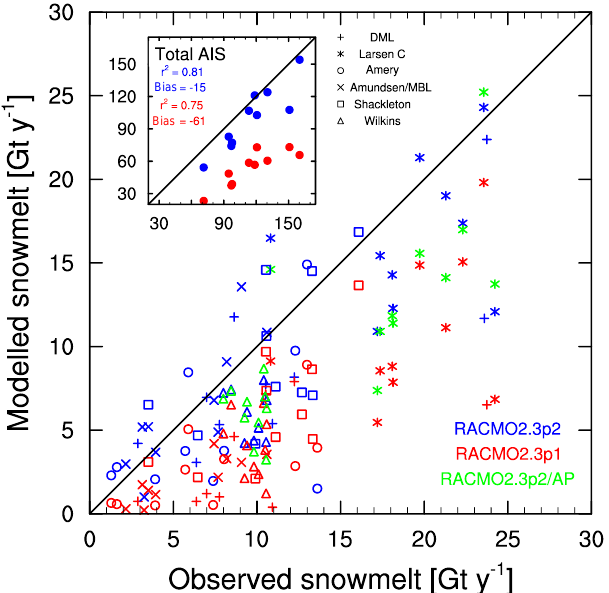
Figure 11. Modelled RACMO2.3p2 (blue), RACMO2.3p1 (red) and RACMO2.3p2/AP (green) as a function of observed QSCAT (Trusel et al., 2013) snowmelt in Gty − 1 . Shown are yearly 2000– 2009 values for the total AIS (subpanel) and area-averaged values for six regions in Antarctica defined in Trusel et al. (2013): Dron- ning Maud Land (DML, plus signs), Larsen C ice shelf (asterisks), Amery Ice Shelf (open circles), Amundsen Sea embayment/Marie Byrd Land (crosses), Shackleton Ice Shelf (squares) and Wilkins Ice Shelf (triangles). Denoted are correlation r 2 and bias for the total AIS.